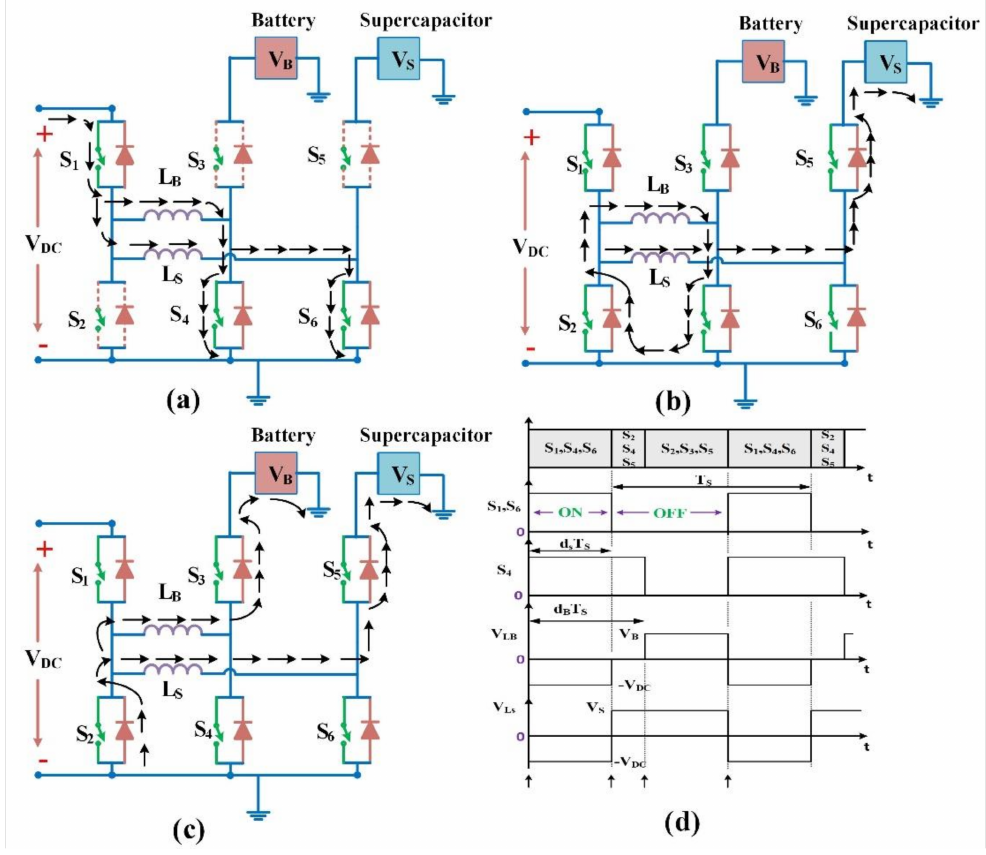
Figure 4. Two-input bi-directional converter equivalent circuit. ( a ) Operating switchesS 1 , S 4 and S 6 ; ( b ) operating switches S 2 , S 4 and S 5 ; ( c ) operating switches S 2 , S 3 and S 5 and ( d ) steady-state waveforms in discharging mode.